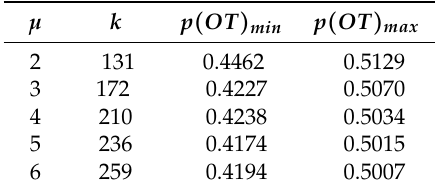
Table 2. The probabilities of Alice breaking Bob’s privacy in our OT 2 denote the maximum probabilities that Alice breaks Protocol 2 with different µ when N =